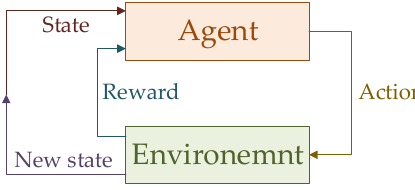
Figure 3. Reinforcement learning